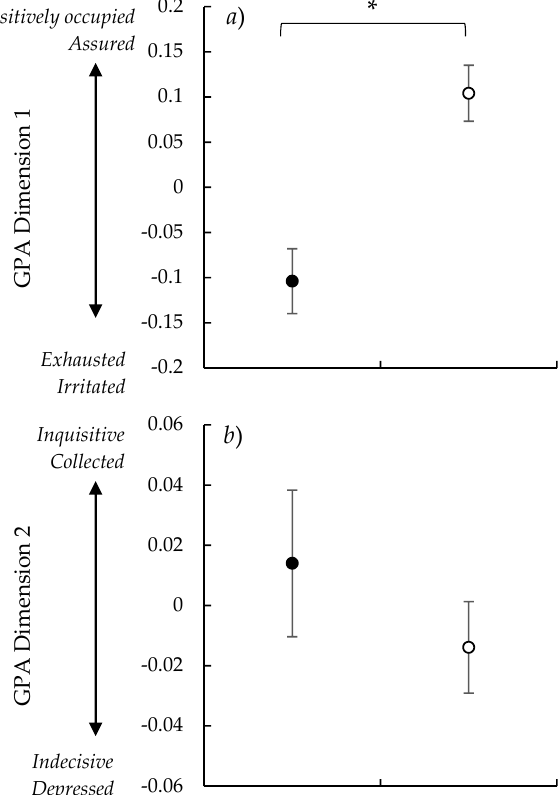
Figure 1. Effects of the treatment groups; flystruck ( n = 8) and non-flystruck ( n = 8) on General Procrustes Analysis (GPA) scores for Qualitative Behavioural Assessment (QBA) ( a ) Dimension 1; and ( b ) dimension 2 assessed from video footage taken of sheep in paddock. Values are means ± S.E.M. Asterisks (*) indicate significant difference between treatment groups ( p < 0.05).